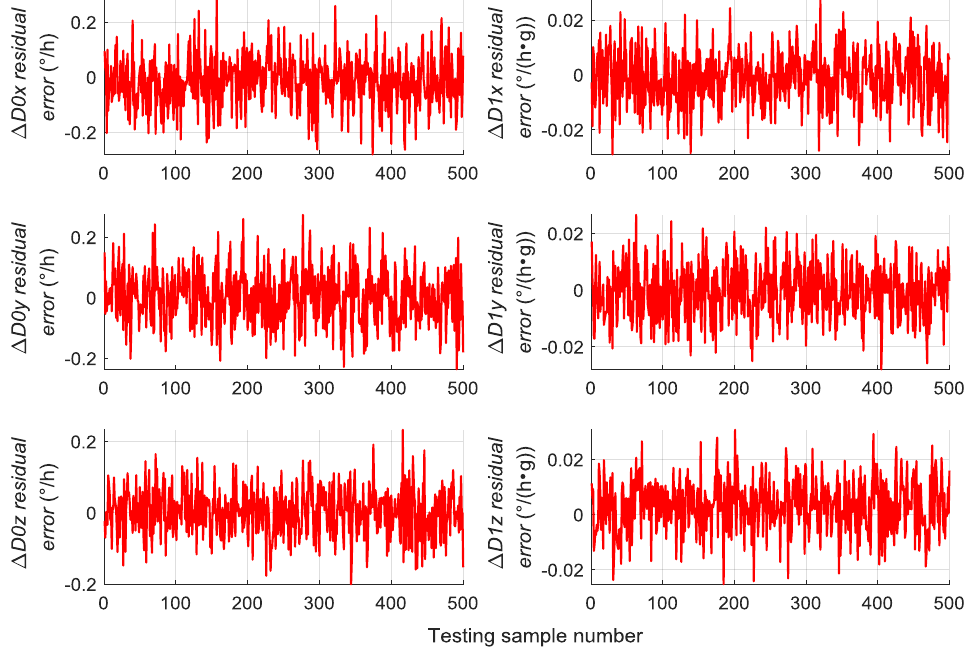
Figure 8. Simulation results of gyroscope residual error using RBM-BPNN method.